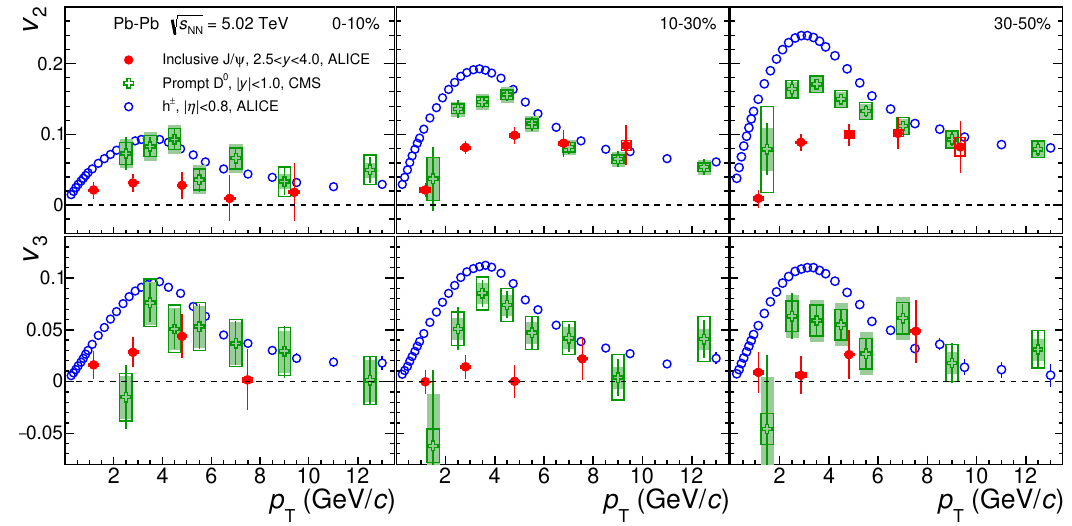
) c (GeV/ p T Figure 4 . (Color online) The J/ v 2 (upper panels) and v 3 (bottom panels) coe(cid:14)cients as a function of p T in three centrality intervals (from left to right) in Pb-Pb collisions at = 5.02 TeV. The results are compared to the v 2 and v 3 coe(cid:14)cients of mid-rapidity charged particles [50] and prompt D 0 mesons [23]. Statistical and systematic uncertainties are shown as bars and boxes, respectively. The shaded bands represent the systematic uncertainties from the contribution of non-prompt D 0